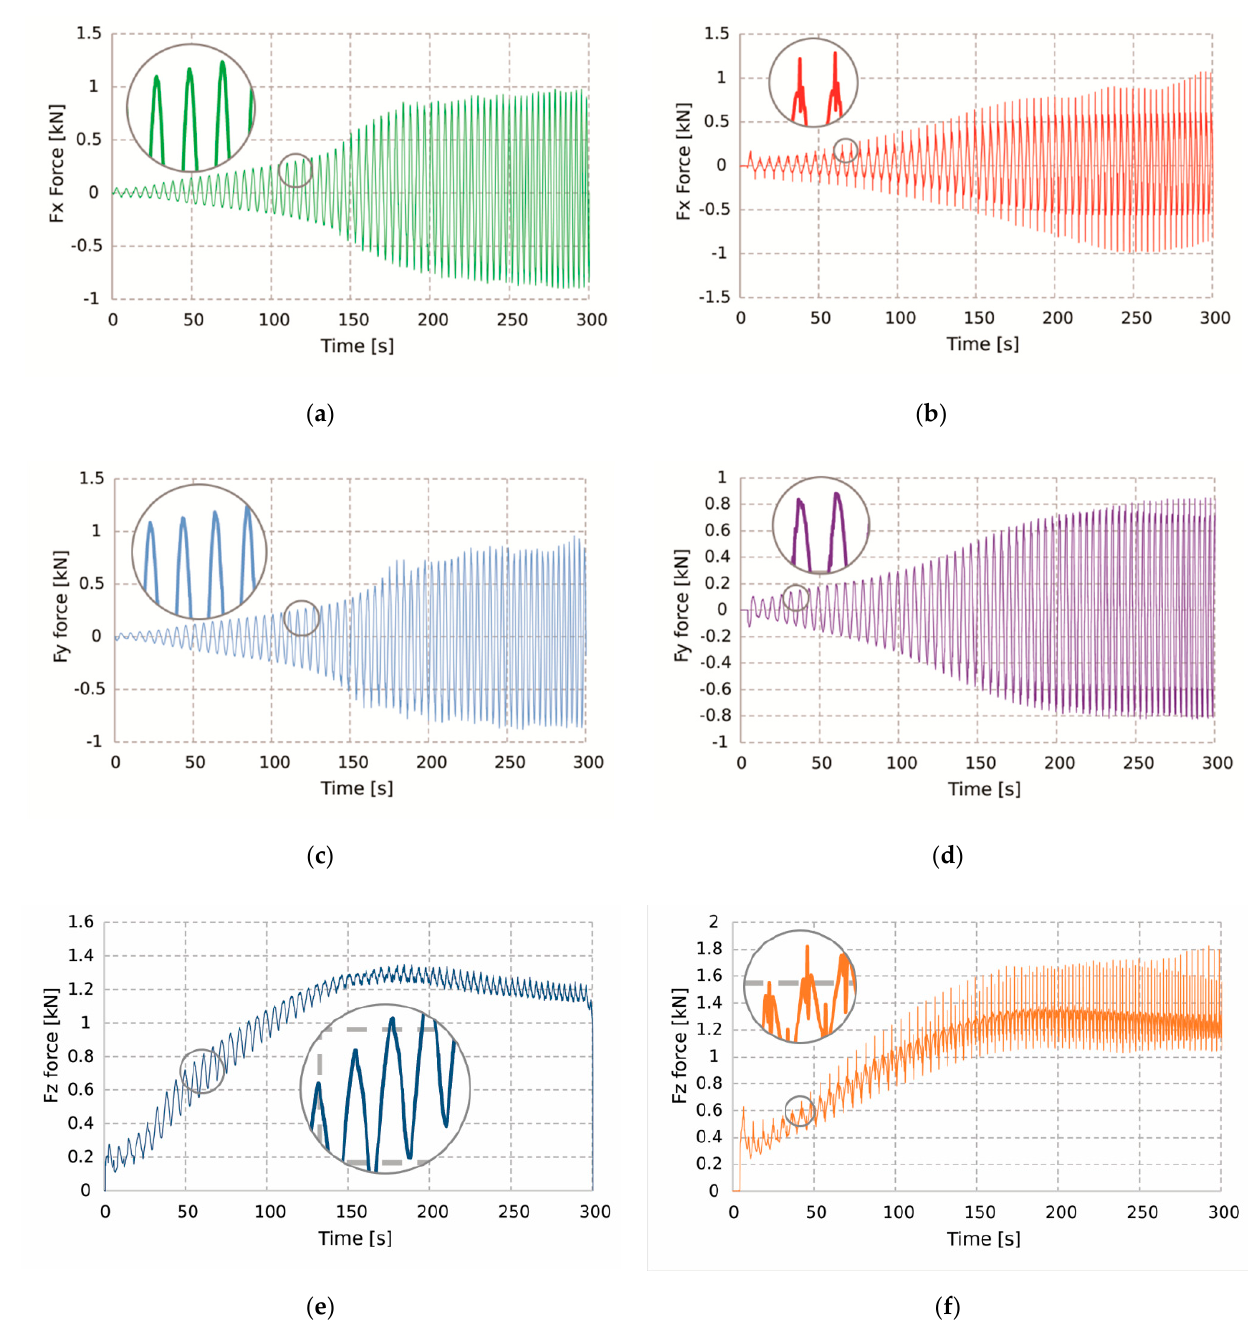
Figure 9. The Fx force variation for unwelded blanks ( a ) and double side welded blanks ( b ), the Fy force variation for unwelded blanks ( c ) and double side welded blanks ( d ) and Fz force variation for unwelded blanks ( e ) and double side welded blanks ( f ) for truncated cone-shaped parts.